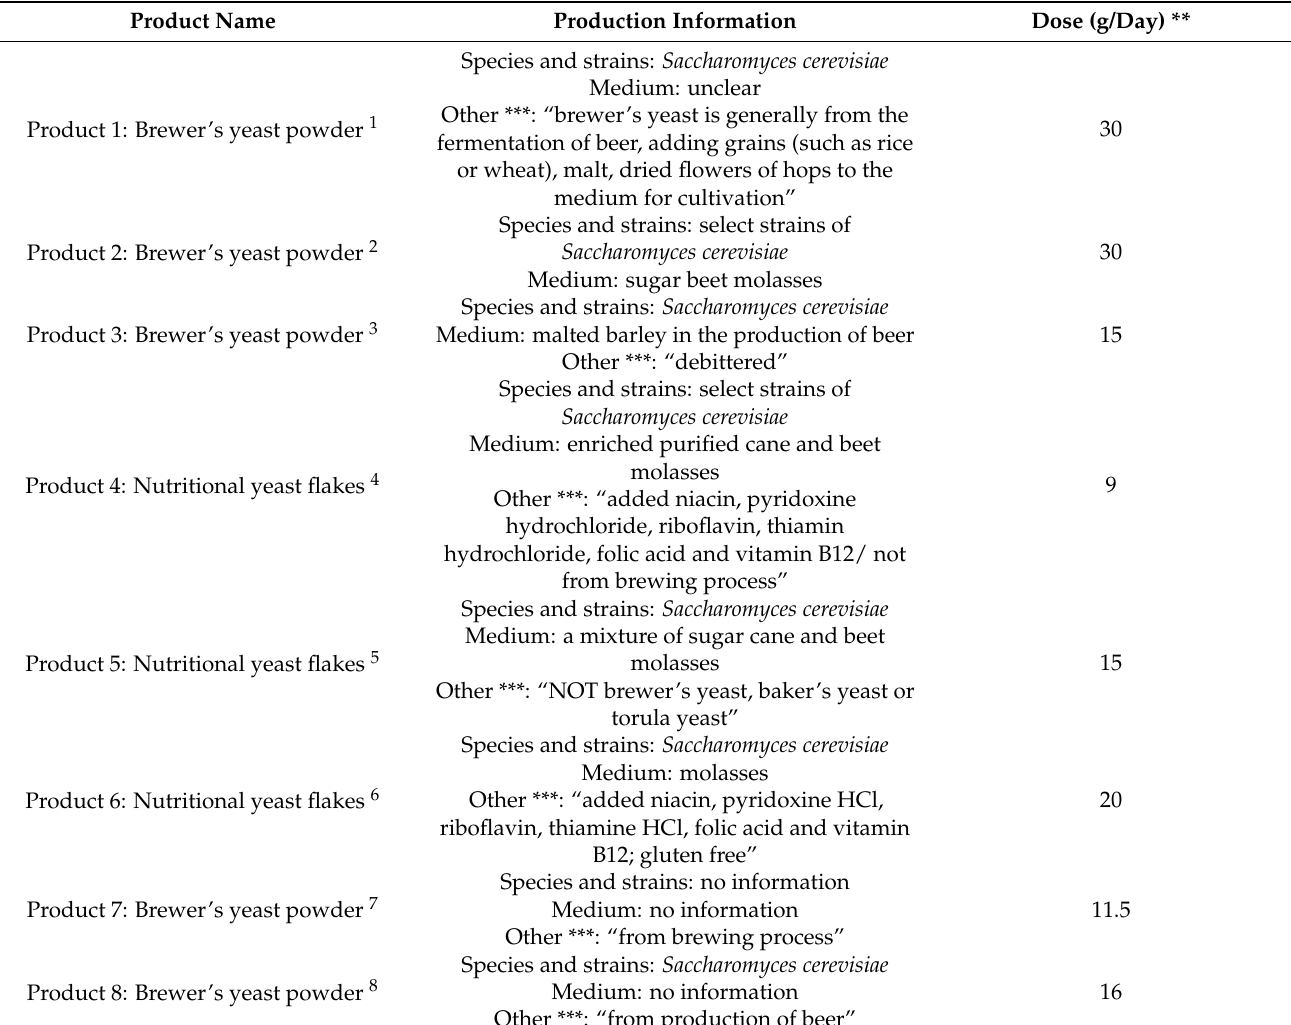
Table 1. A selection of information on Saccharomyces cerevisiae yeast-based supplements (SCYSs) available on the internet